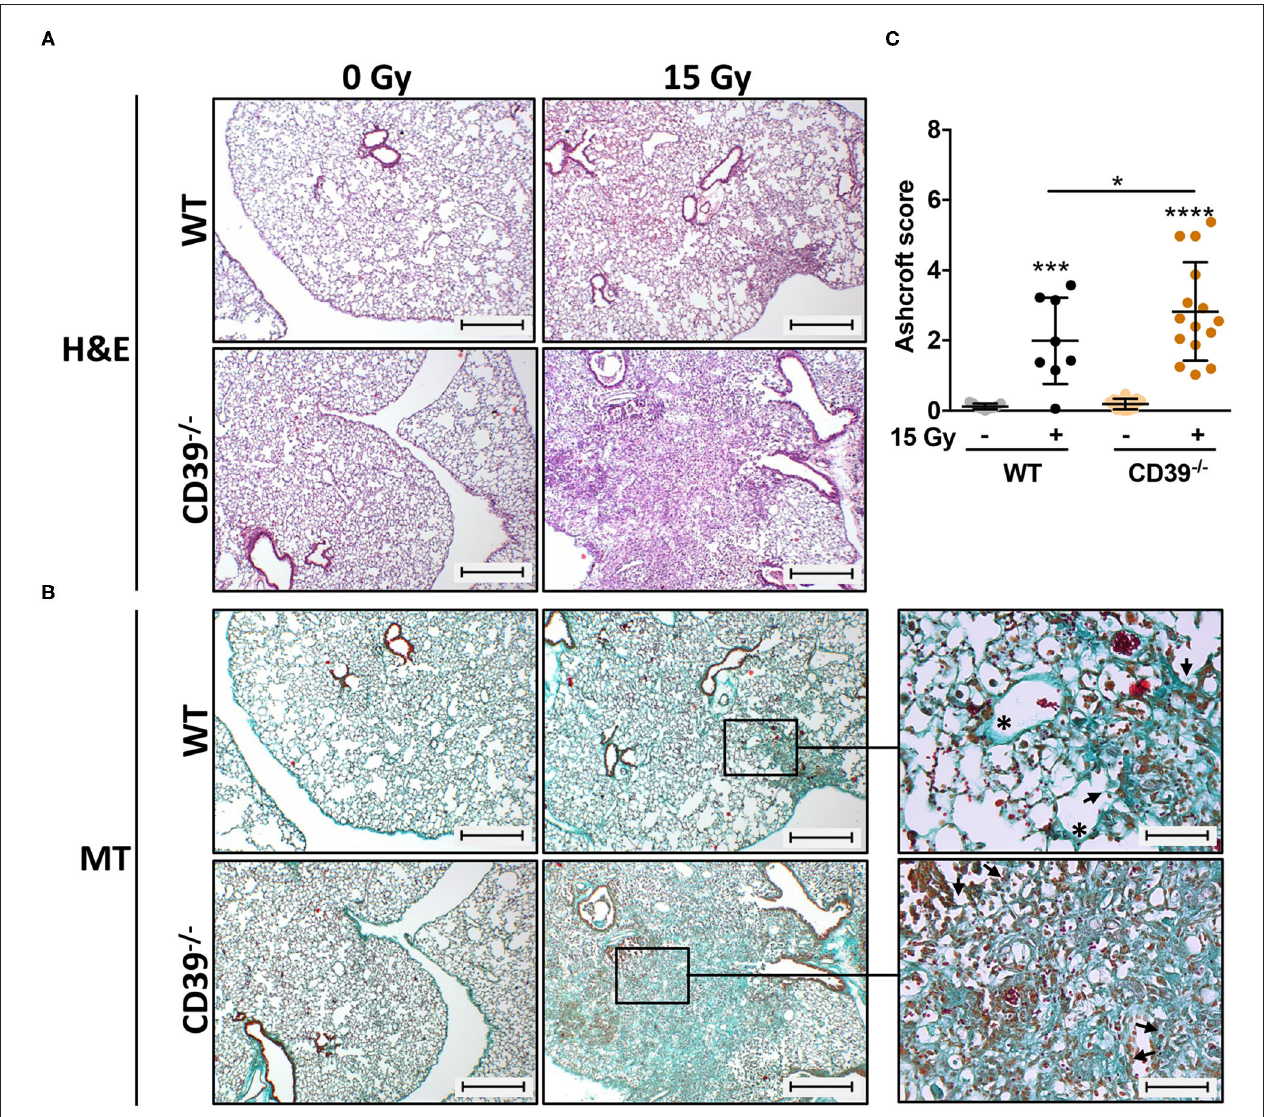
FIGURE 8 | CD39 − / − mice develop enhanced pulmonary fibrosis 25 weeks after irradiation. C57BL/6 (WT) and CD39 − / − mice received 0- or 15-Gy whole-thorax irradiation (WTI) and were sacrificed at 25 weeks after irradiation. (A) Hematoxylin-eosin (H&E) or (B) Masson Goldner trichrome (MT) stained lung sections at 25 weeks after irradiation. Lung sections were evaluated for fibrosis by using 10 non-overlapping randomized pictures (scale bar = 100 µ m) per slide. Ashcroft scoring was done by three independent observers on slides blinded to the genotype and treatment condition. Magnified pictures (400-fold) highlight special structures. Asterisks emphasize thickening of alveolar wall structures and arrowheads fibrotic regions. (C) Quantification of fibrosis in WT ( n ≥ 7) and CD73 − / − ( n = 7) mice, horizontal lines represent mean values. * P ≤ 0.05, *** P ≤ 0.001, **** P ≤ 0.0001 by one-way ANOVA followed by post hoc Newman–Keuls test, n = 9/9/15/15.